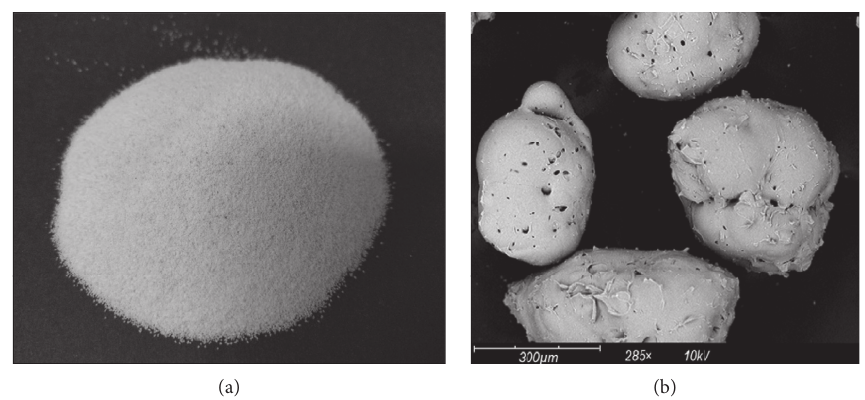
Figure 1: (a) Physical appearance of PM; (b) SEM image of PM.